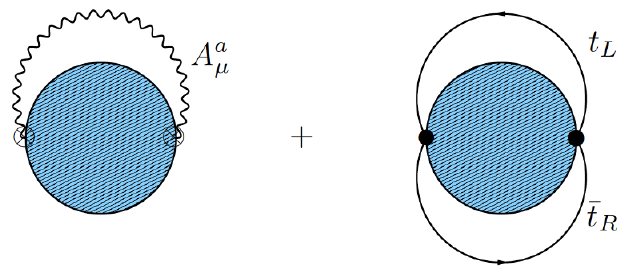
Figure 5 . The SM corrections to the vacuum energy. The blob denotes the (full) two-point function of the strong dynamics of the composite Higgs. The curly line denotes the SM gauge bosons, A a and the solid line denotes the SM fermions such as the top